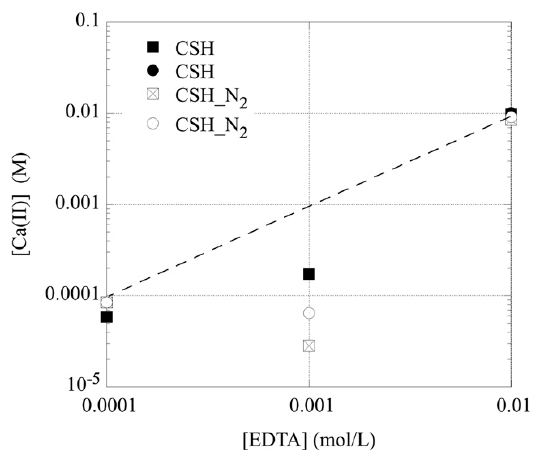
Figure 3. Calcium (Ca-EDTA) concentration in solution as a function of the initial EDTA concentra- tion.